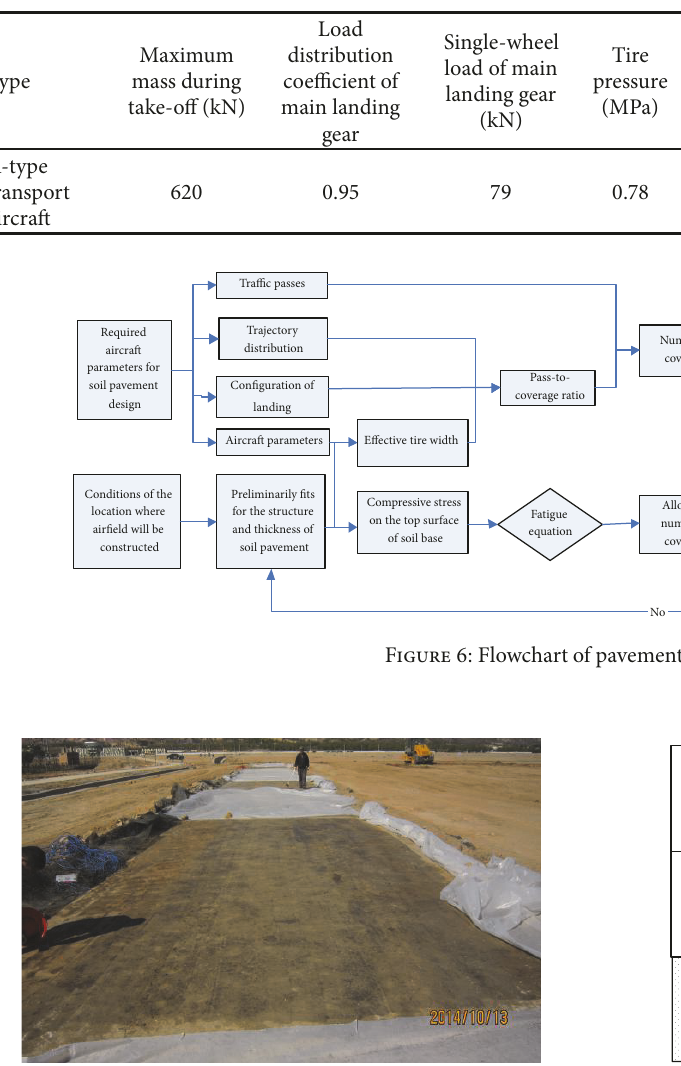
Table 2: Partial parameters of A-type transport aircraft.